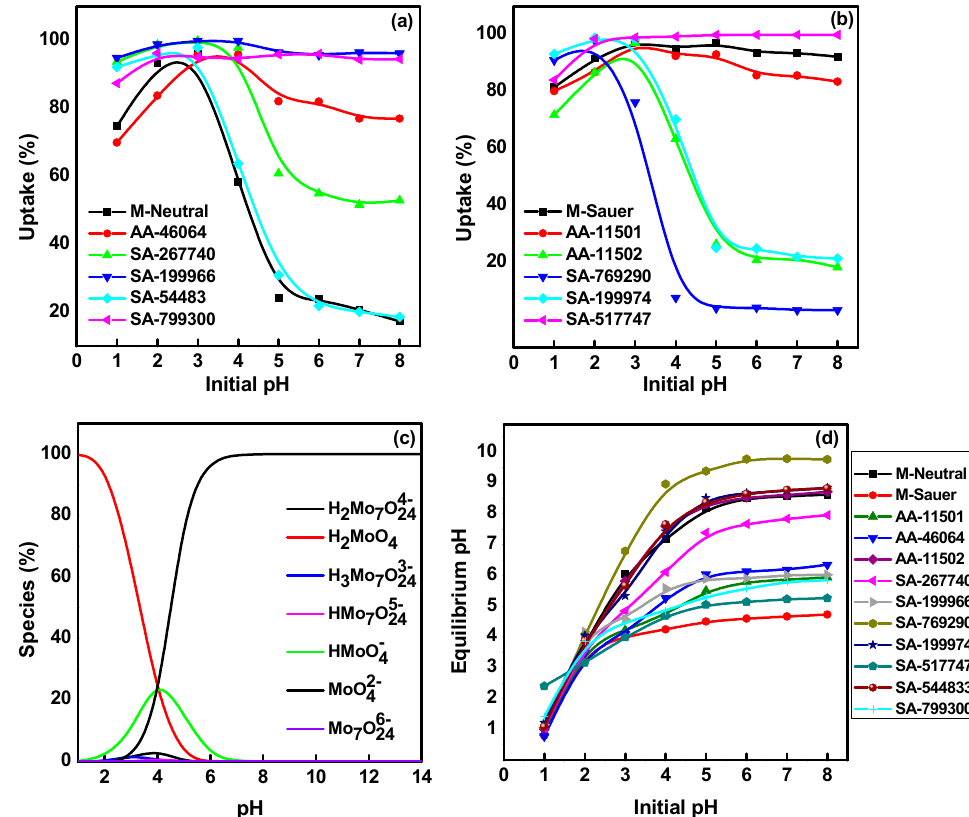
Figure 1. Effect of initial pH ( a , b ) on the uptake of CA- 99 Mo on different alumina adsorbents (C o = 50 mg/L, V/m = 100 mL/g, and temperature = 25 ± 1 o C), ( c ) speciation of molybdenum, and ( d ) variation of the equilibrium pH values.